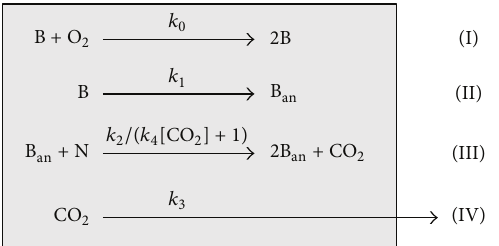
Scheme 1: Kinetic scheme composed of four irreversible processes to reproduce SA/V-dependent bacterial growth curves; B = aerobic bacteria, B an = anaerobic bacteria, and N = nutrient. The parameter expression 𝑘 2 /(𝑘 4 [ CO 2 ] + 1 ) in step (III) represents the autoinhibi- tion by CO 2 where 𝑘 4 is a control parameter to tune the inhibition strength. The reaction arrow in step (IV) symbolizes the physical escape of CO 2 from the